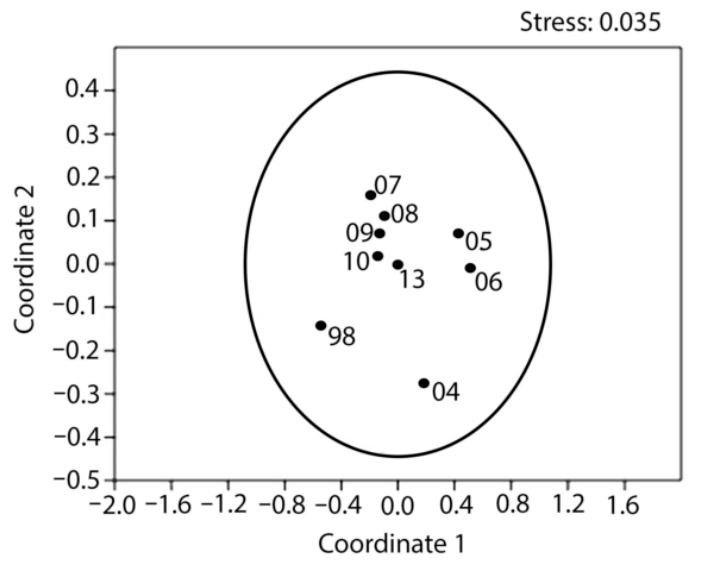
Figure 5. Multidimensional scaling (MDS) of population size/age structure in different years. The closeness of one sample to another (belonging to a different year) is a measure of similarity. The elliptical area represents 95% confidence. The 1998 pristine structure is set apart from the others, while all the years between 2007 and 2013 are grouped together. The 2005–2006 cluster likely represents an intermediate point between the pristine structure and the subsequent partial recovery.